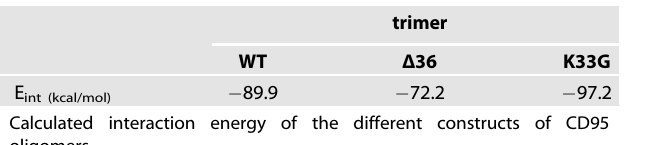
Table 1. CD95 trimer interaction energy. Table 2. Stability of K33G CD95